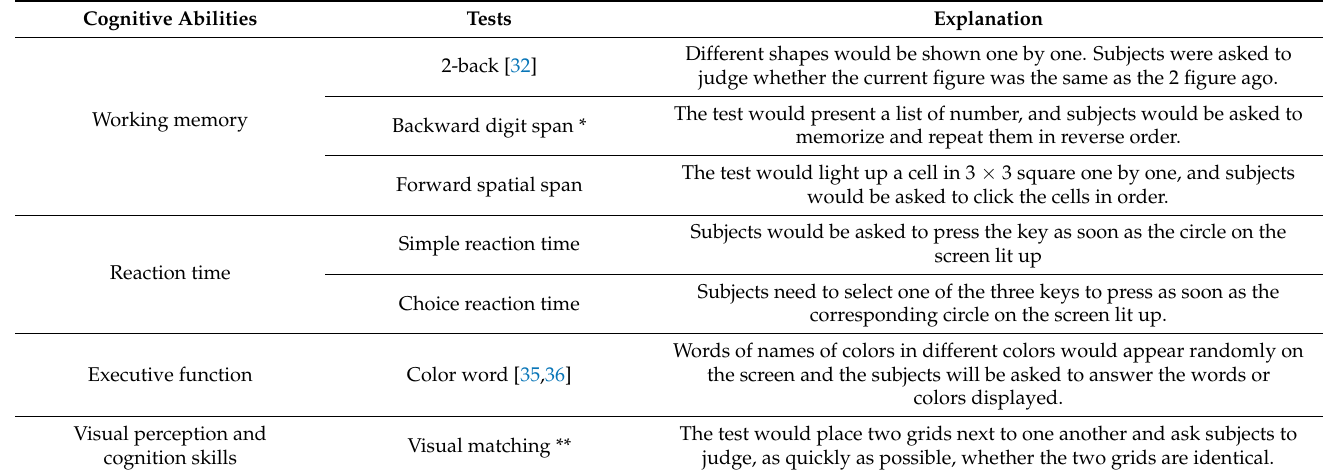
Table 1. Cognitive abilities and their